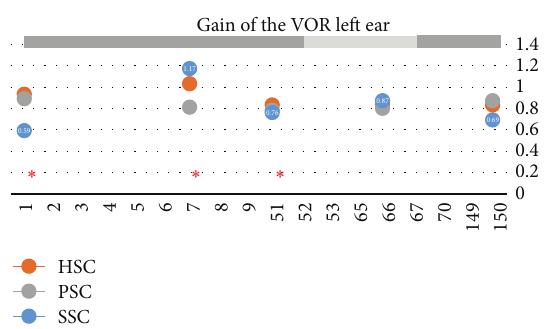
Figure 2: Gain of the vestibuloocular reflex in the left ear three semicircular canals at different follow-ups. Day 1 was the day of the first treatment with gentamicin intratympanically (that and the others are represented by ∗ ). In light grey, the dates the patient felt steady and free of vertigo